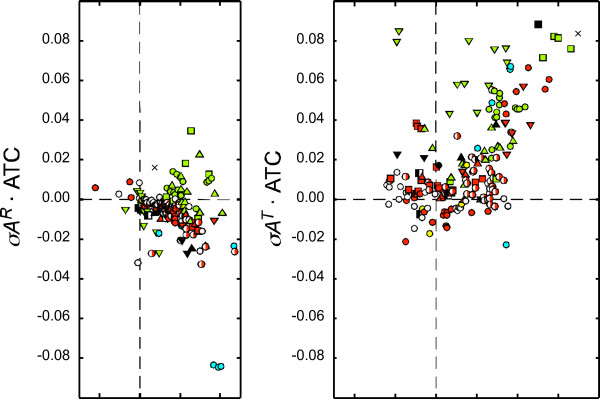
Examination of cytosine deamination effect. G+C content-adjusted σGR (σGR·GCC) is plotted against A+T content-adjusted σAR (σAR·ATC; left panel), and G+C content-adjusted σGT (σGT·GCC) is plotted against A+T content-adjusted σAT (σAT·ATC; right panel) for the 185 bacterial chromosomes. The symbols are as in Figure 1.